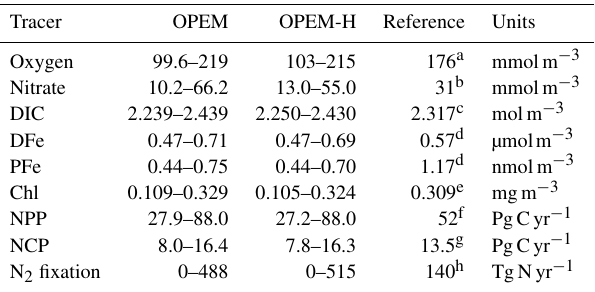
Table 2. Ranges of global averages of major tracer concentrations or fluxes in the OPEM and OPEM-H configurations. Chl concentration is for the upper 50m (surface layer of the UVic grid) and NCP is for the upper 100m. Observations and reference model simulations are listed in the Reference